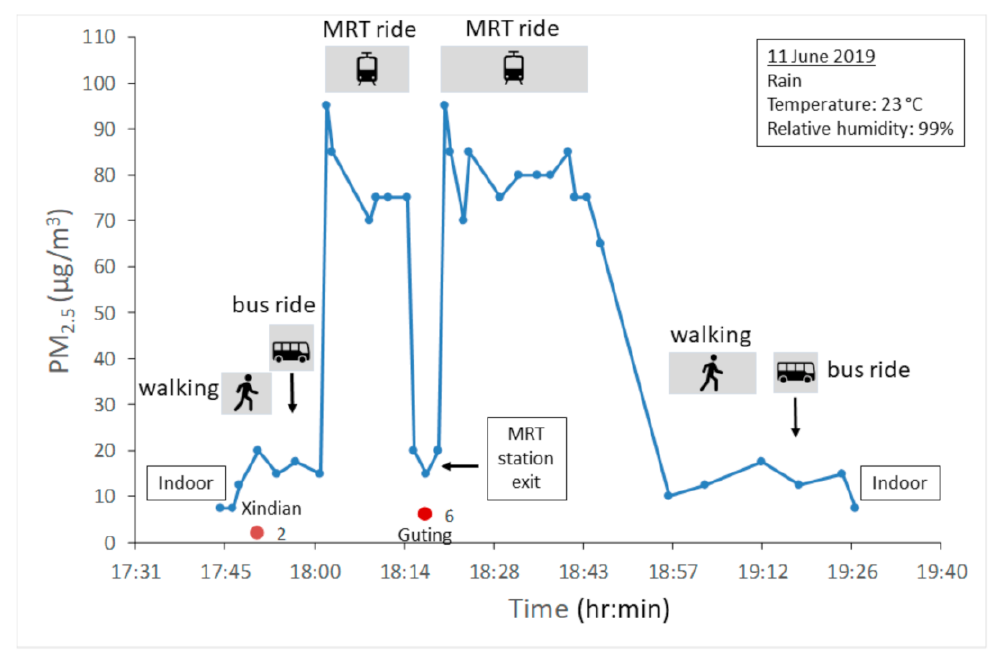
Figure 4. PM 2.5 concentrations during a trip from home to the workplace that used primarily two underground mass rapid transit (MRT) lines. MRT: mass rapid